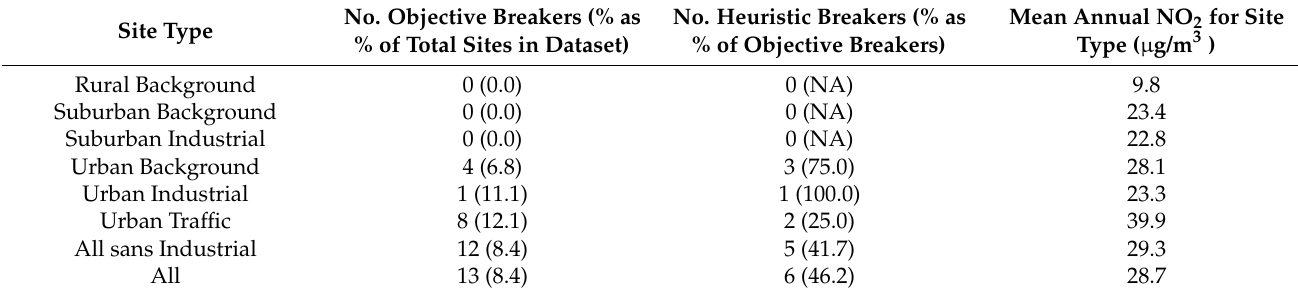
Table 2. A table which examines how many objective breaking sites (sites with >18 exceedances of 200 µ g/m 3 ) are also heuristic breaking sites (having at least one objective breaking year with an annual mean <60 µ g/m 3 ) as a function of site type for the Defra